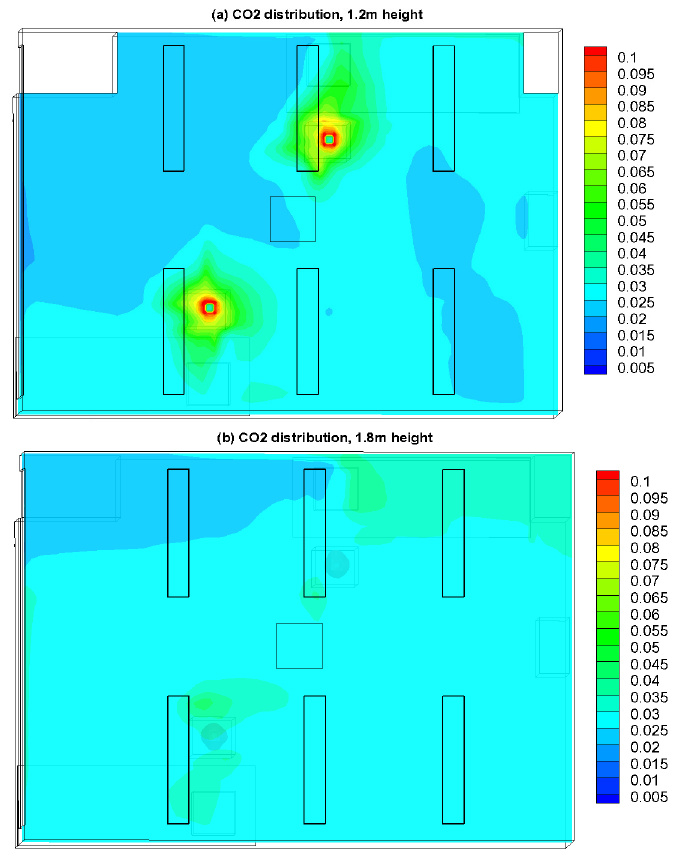
Figure 12. Resulted CO 2 fraction distribution at: ( a ) sitting height (1.2 m ); and ( b ) standing height (1.8